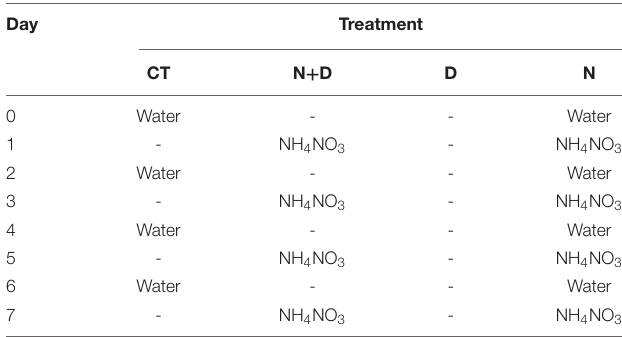
TABLE 2 | Timing of water and nitrogen application for the four groups of the treatments in this experiment. Day Treatment